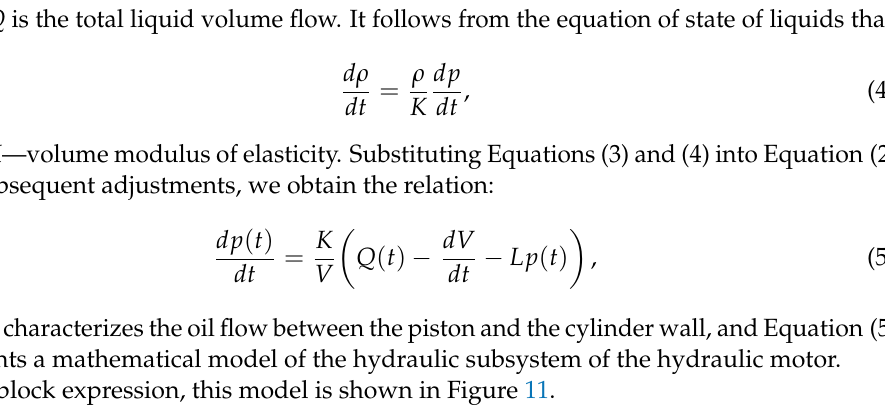
Figure 10. Hydraulic subsystem of the hydraulic motor.